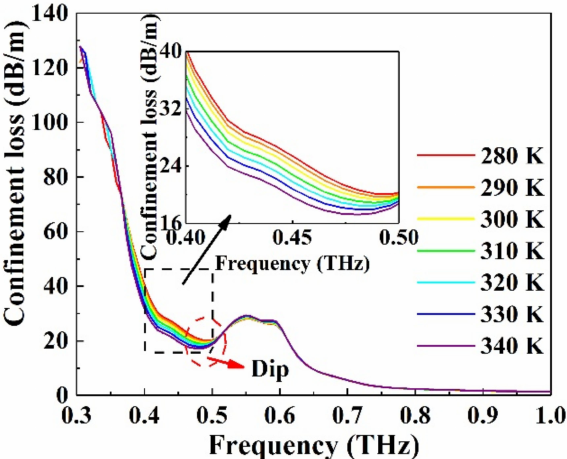
Figure 7. Confinement loss with water for various temperatures. The inset: the detailed information of the confinement loss ranging from 0.4 THz to 0.5 THz.